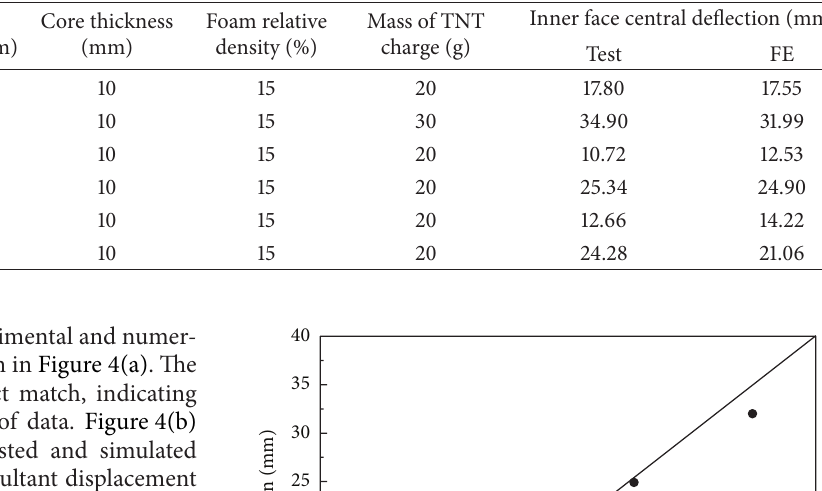
Table 3: Specifications of curved sandwich panels and experimental [17] and numerical results.